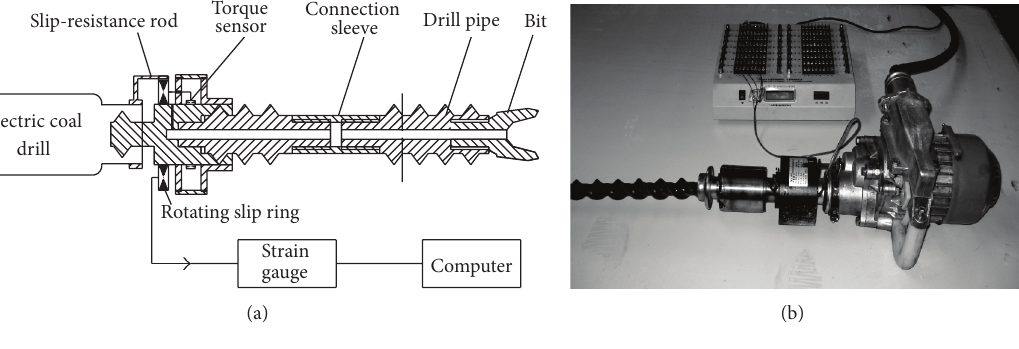
Figure 3: Drill pipe torque test equipment.